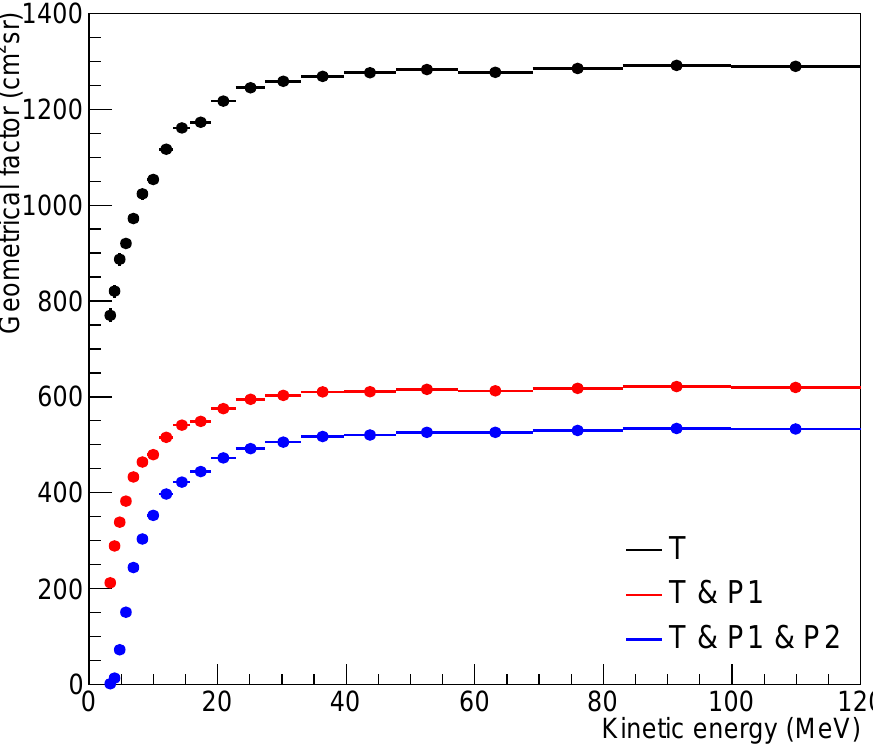
Figure 2. The HEPD geometrical factor for electrons, as estimated from Monte Carlo simulations, as a function of kinetic energy and trigger